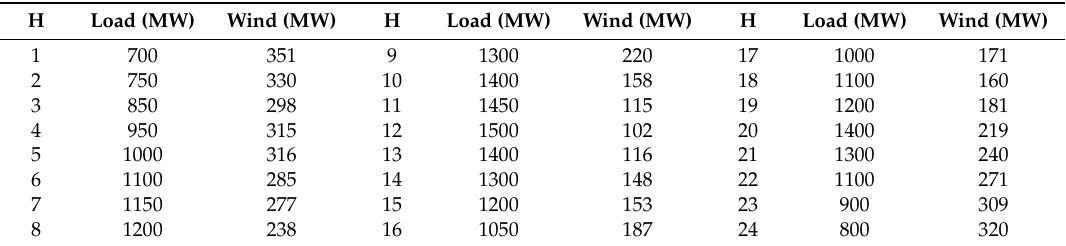
Table 2. Forecast hourly load and wind generation. These data were obtained from the EirGrid website [28]. H Load (MW) Wind (MW) H Load (MW) Wind (MW) H Load (MW) Wind (MW)